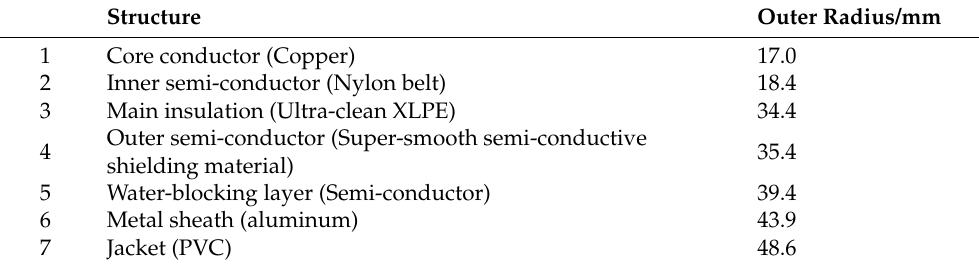
Table 3. The cross-sectional structure parameters of the HV